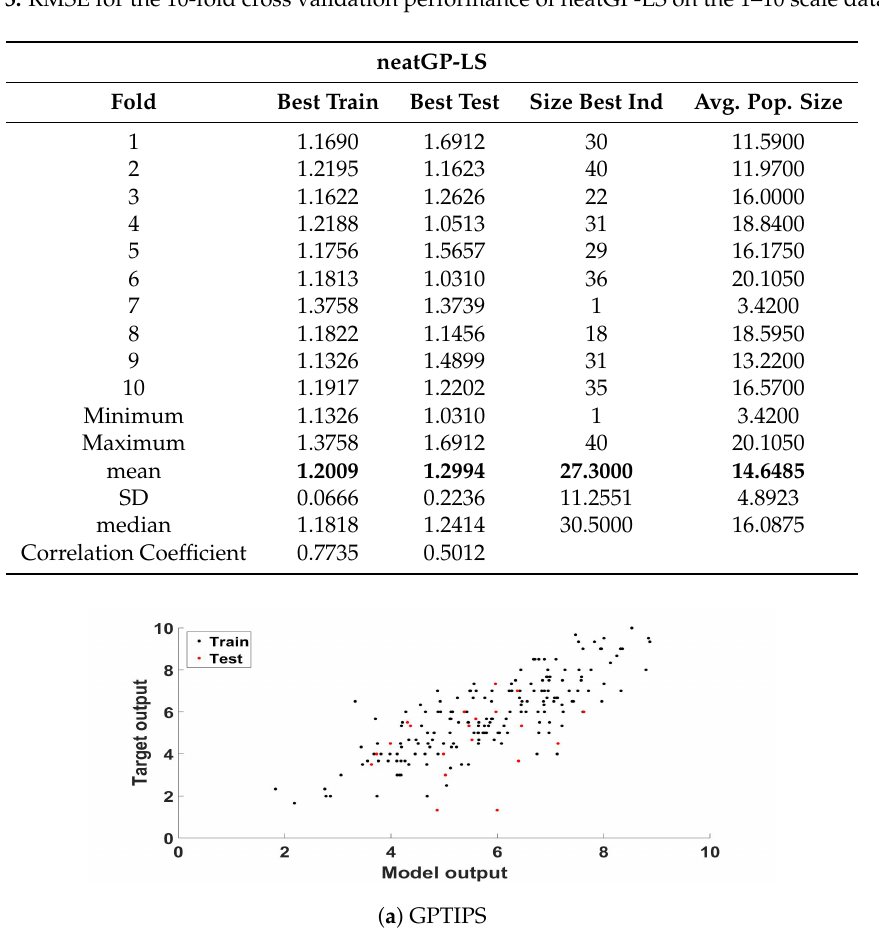
Table 5. RMSE for the 10-fold cross validation performance of neatGP-LS on the 1–10 scale